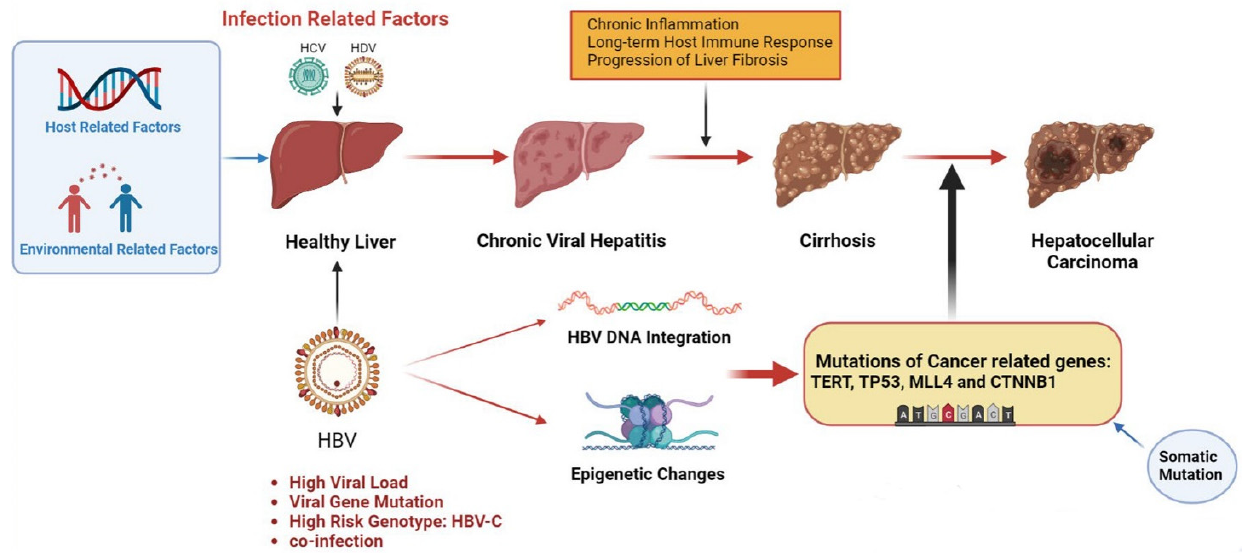
Figure 1. Pathogenesis of infection-induced hepatocellular carcinoma. Infectious factors include HBV, HCV and HDV, which mainly mediate chronic inflammation and persistent immune response through chronic viral hepatitis, leading to liver fibrosis and cirrhosis, inducing somatic mutations, and eventually leading to HCC. HBV infection is a major infectious factor with a unique oncogenic mechanism. HBV can cause cancer-related gene mutations through gene integration and epigenetic changes and promote the occurrence of HCC. Other virus-related risk factors include high viral load, viral gene mutations and high-risk genotypes. Environmental and host-related factors play a synergistic role. The figure material is referenced from Biorender.